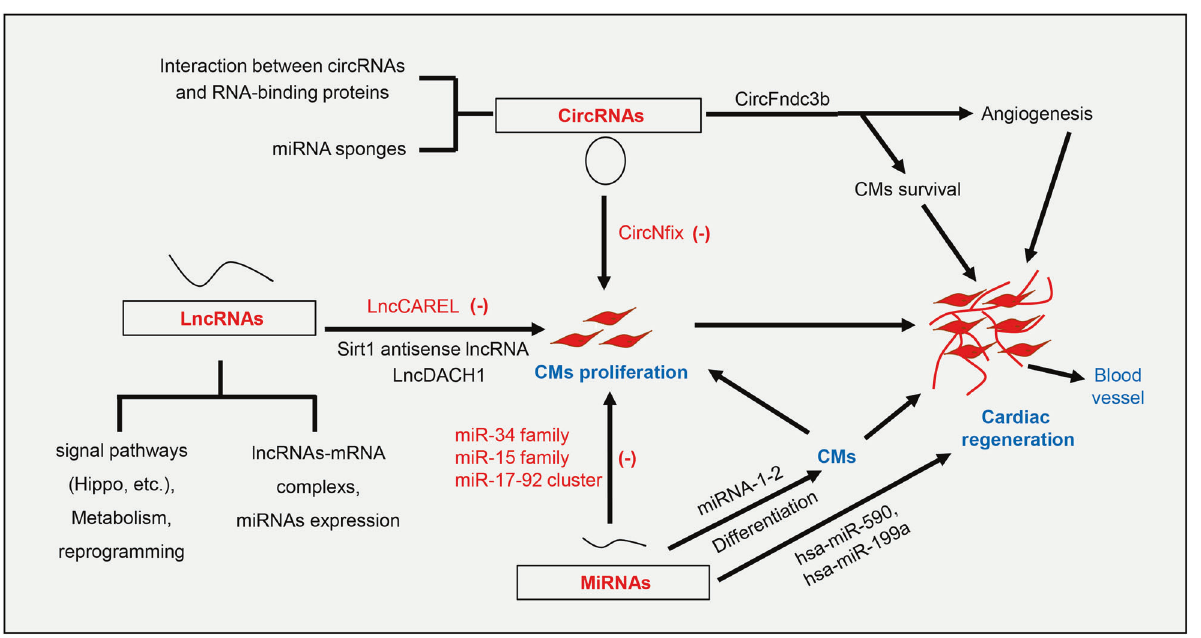
Fig. 4 The vital regulatory roles of non-coding RNAs in cardiac regeneration after injury. MiRNAs regulate the critical process of heart repair and subsequent remodeling after infarction. Among them, miRNA (miR-34 family, miR-15 family, and miR-17-92 cluster), lncRNA (LncCAREL) and circRNA (CircN fi x) negatively regulate the proliferation of cardiomyocytes. CircRNAs also play a critical role in controlling cardiomyocyte proliferation, angiogenesis and even tissue regeneration. CMs cardiomyocytes, CircRNA circular RNA, LncRNA long non-coding RNA, miRNAs microRNAs. (-):